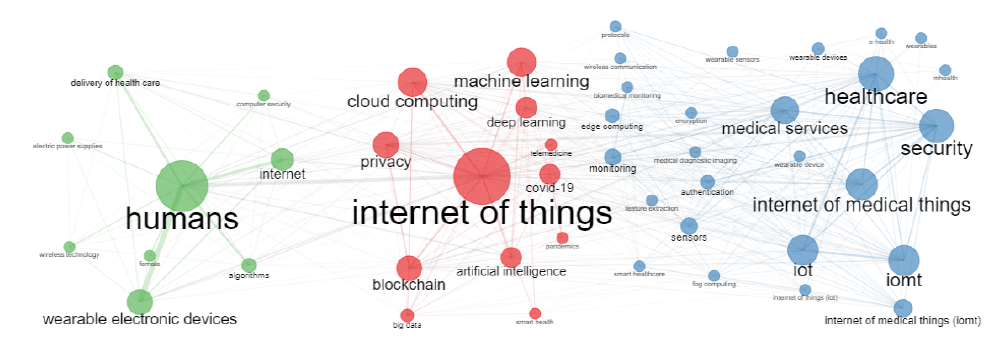
Figure 13. Co-occurrence Network.